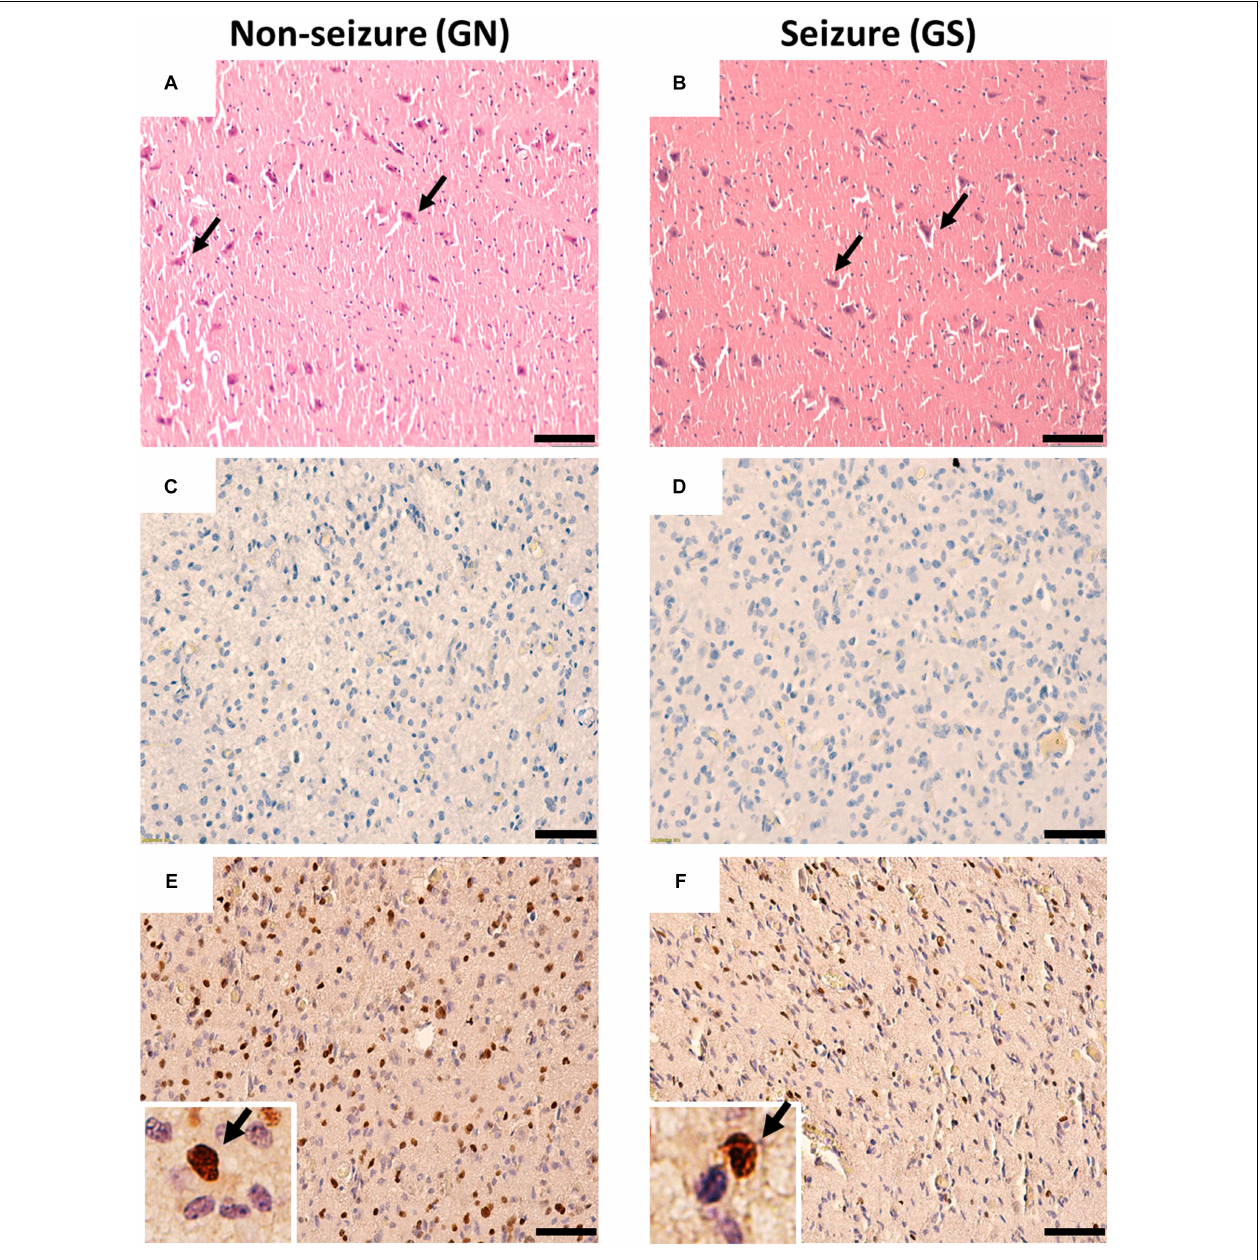
FIGURE 1 | Cytoarchitecture of resected peritumoral specimens obtained from glioma patients without (GN) and without (GS) history of seizures. (A,B) H&E staining of peritumoral tissue sections from GN and GS patients showing mature pyramidal neurons (arrowheads), absence of gliosis, and tumor cell infiltrations. (C,D) Ki67 immuno-positive cells were absent in tissue sections from GN and GS patients. (E,F) Olig2 immuno-positive cells were scattered in tissue sections from GN and GS patients. OLig2 cells (brown) are marked with arrowheads (inset). The nuclei are stained with hematoxylin (blue). Scale bar, 50 µ m.